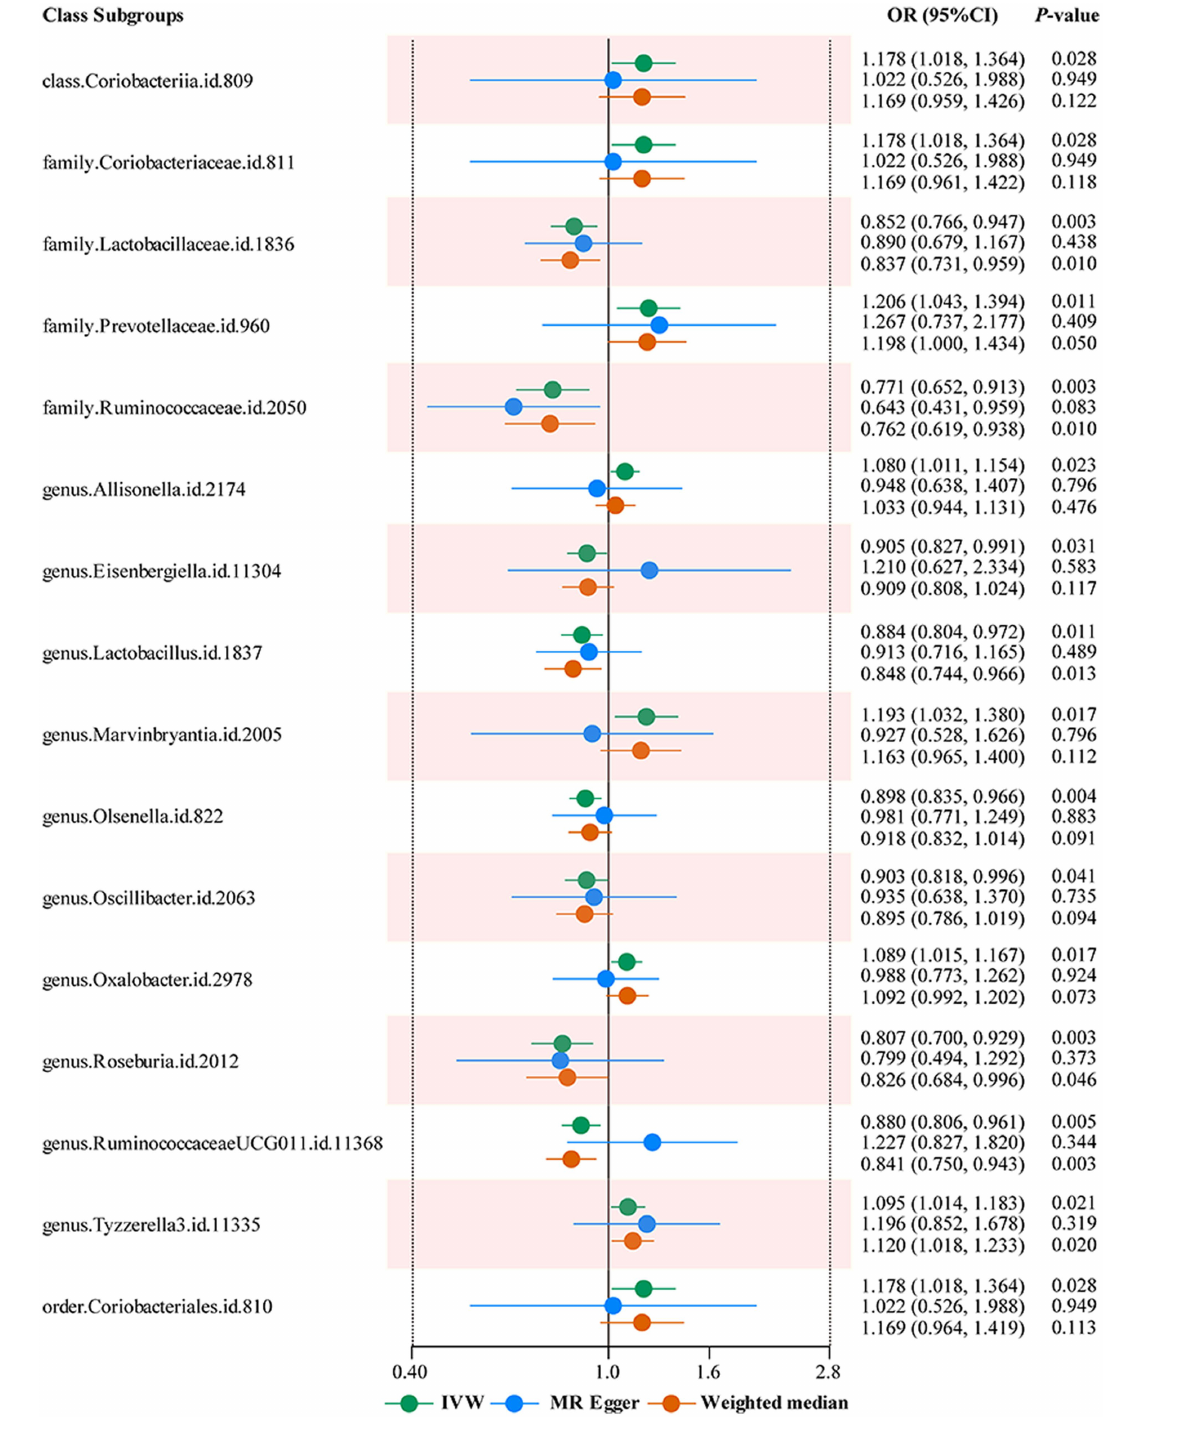
FIGURE 2 Forest plots summarizing the Mendelian randomization results of gut microbiota taxa with a causal relationship to low back pain. OR, odds ratio; CI, confidence interval; IVW, inverse variance weighted; MR, Mendelian